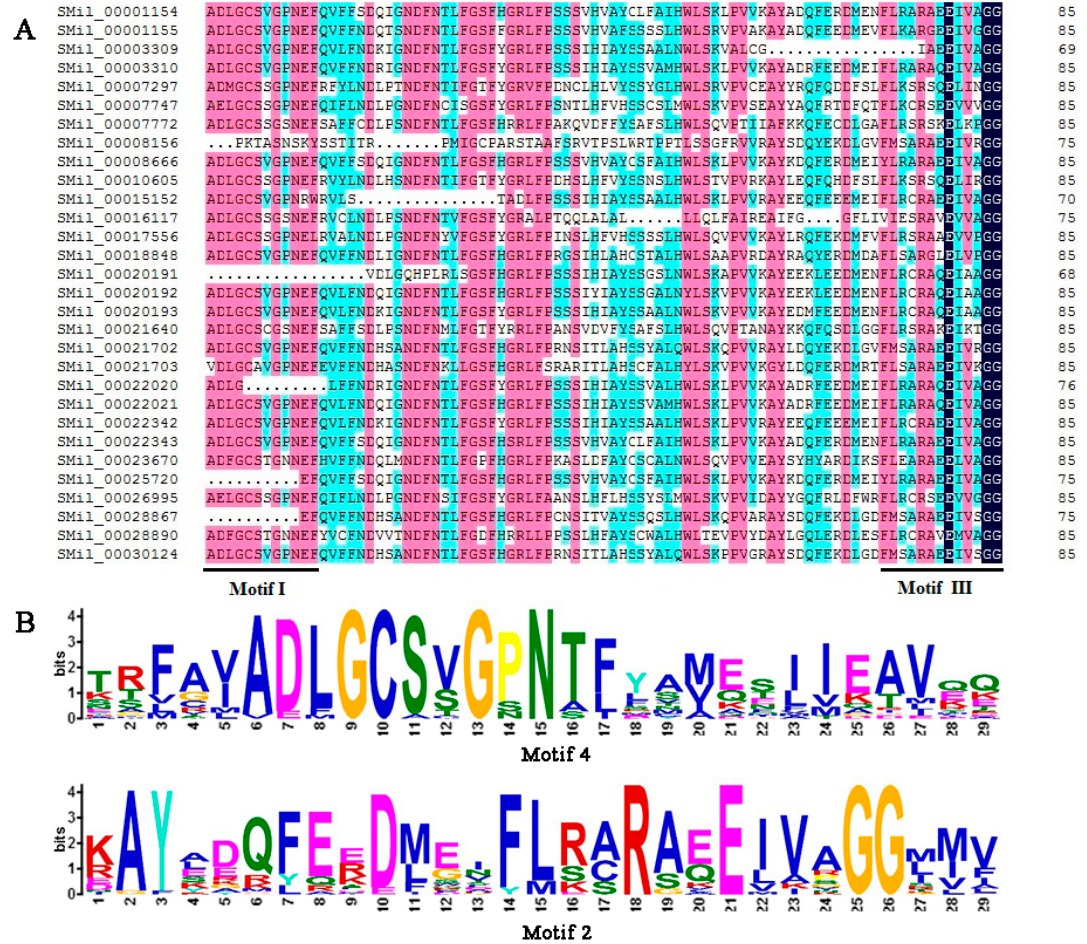
Figure 3. ( A ) Multiple sequence alignments of the SmSABATH proteins’ conserved domain of O -methyltransferases, including the binding sites (motifs I and III were indicated) of S -adenosyl- L -methionine. ( B ) Sequence logo of two conserved motifs; motif 4 and motif 2.